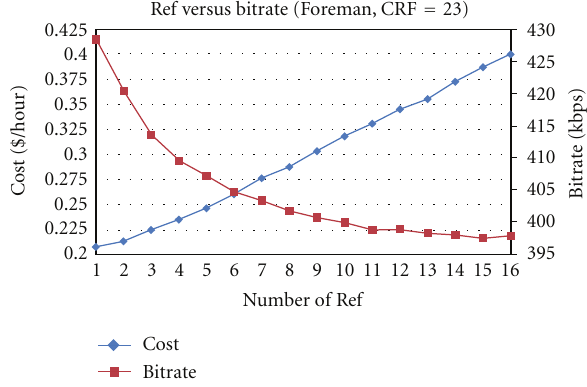
Figure 8: Bitrate and cost with varying Ref number (Foreman, crf = 23).